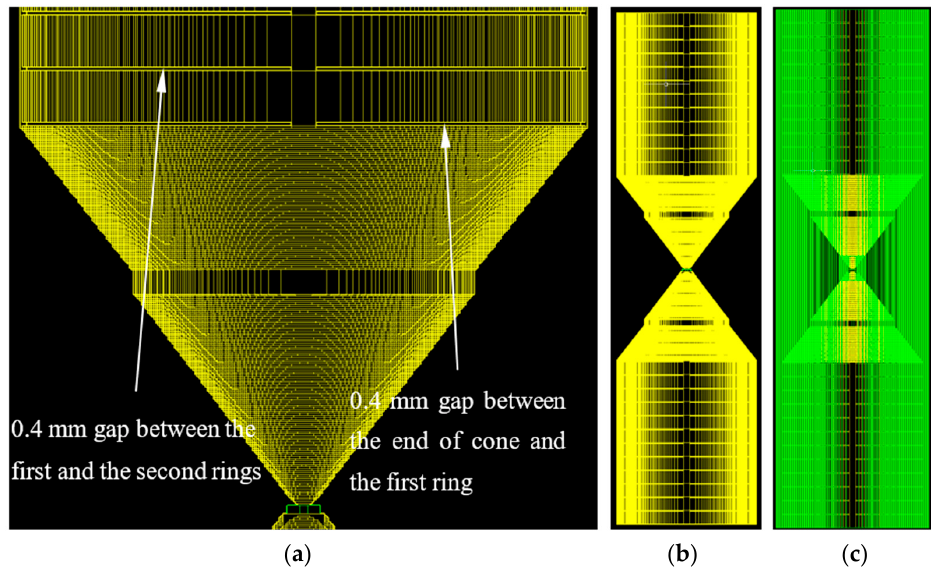
Figure 13. ( a ) Details of how the metallic rings are stacked to the base MBA; ( b ) a view of the base MBA with 12 rings (to be called 24-ring-loaded MBA) on each side of the cone without inner dielectric ring and cover; ( c ) a wireframe view of the 24-ring-loaded MBA with both inner dielectric ring and cover. The total length of the 24-ring-loaded MBA is 203 mm, which is about 0.3 wavelength of the low end of frequency.